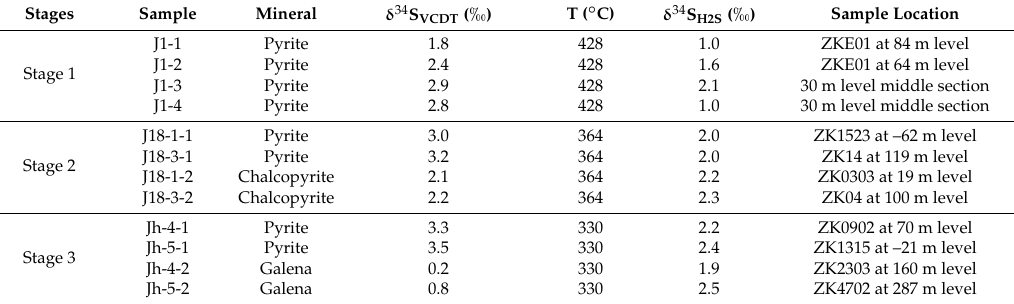
Table 3. Sulfur isotope data for ore minerals of the Jinchang deposit.